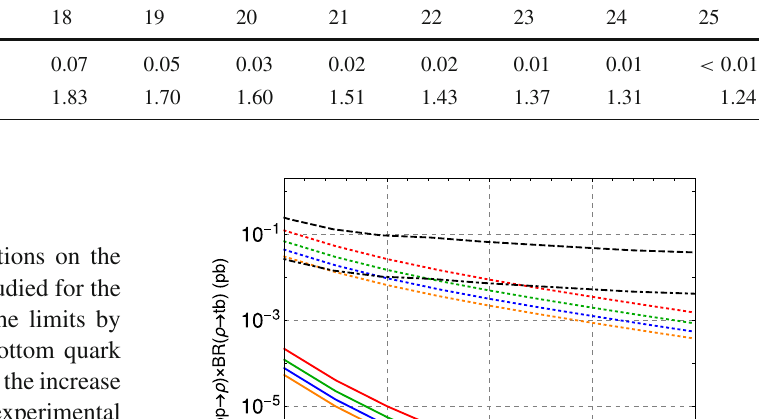
Table 2 The mass exclusion limits (MEL) for the tBESS vector resonance triplet without direct interactions for various values of g (cid:2)(cid:2) . The second row contains the values of the resonance fatness. All MEL values shown in the table indicate the upper boundaries of the mass exclusion region g (cid:2)(cid:2)